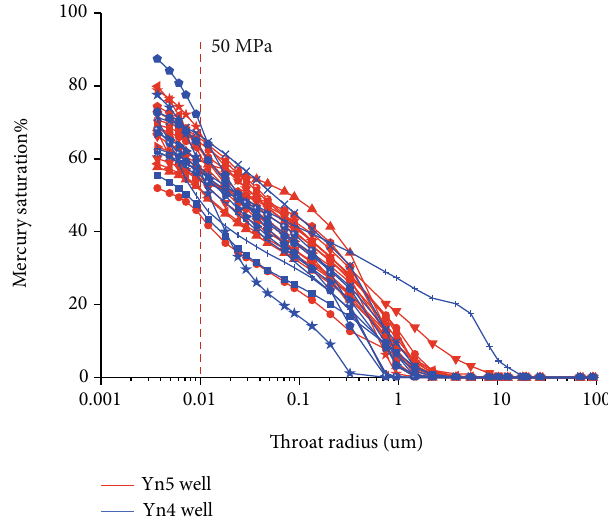
Figure 7: HPMI curve feature of tight sandstone reservoirs in Dibei